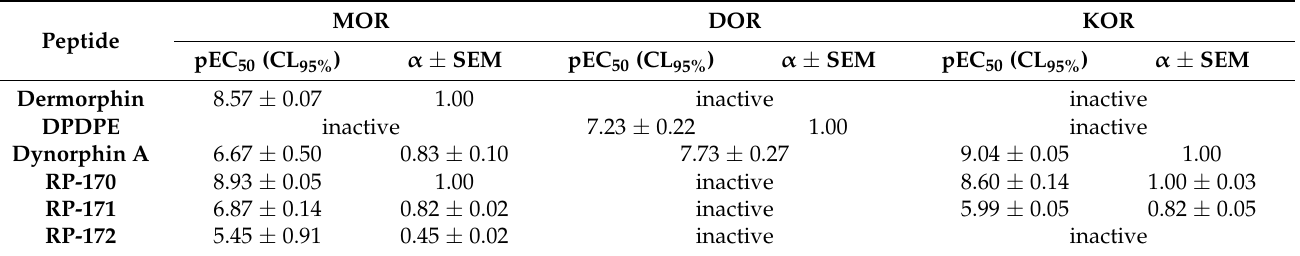
Table 2. Effect of new analogs at human recombinant opioid receptors coupled with calcium signaling via chimeric G